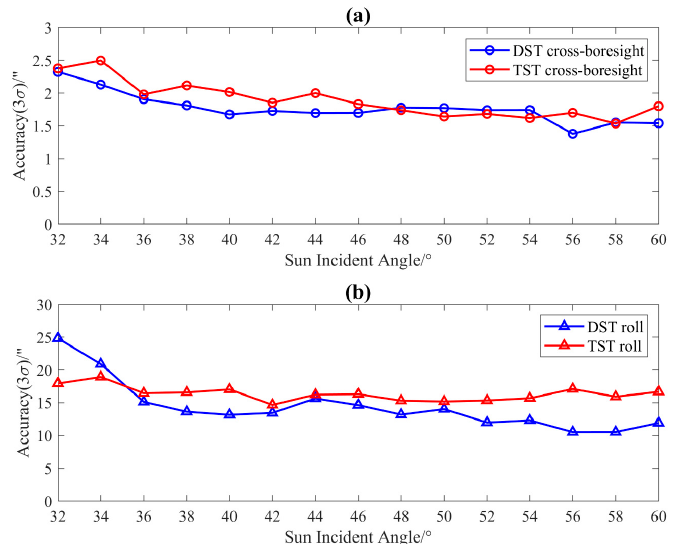
Table 6. The cross-boresight and roll axis average accuracy ( 3σ ) for two star trackers.